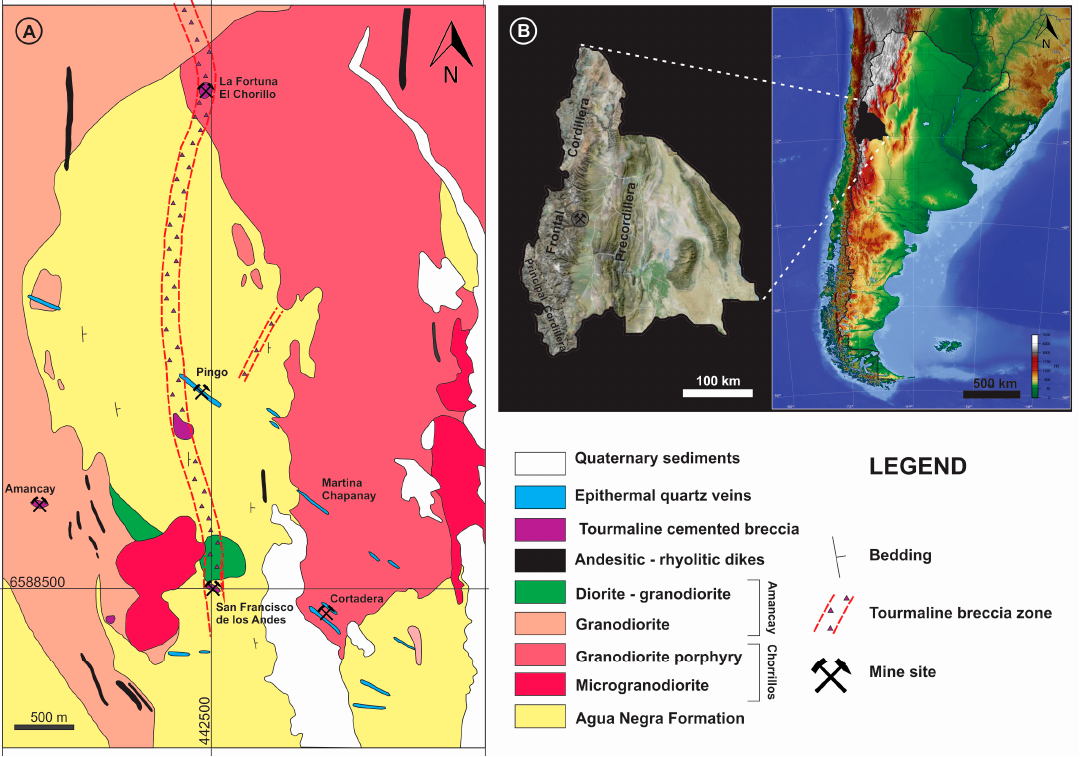
Figure 1. ( A ) Geological maps of the southern area of the San Francisco de los Andes district (modified after Llambías and Malvicini, 1969 [37]). ( B ) Location of Frontal Cordillera and San Francisco de los Andes mine in San Juan Province (left); and San Juan’s location in Argentina (right).